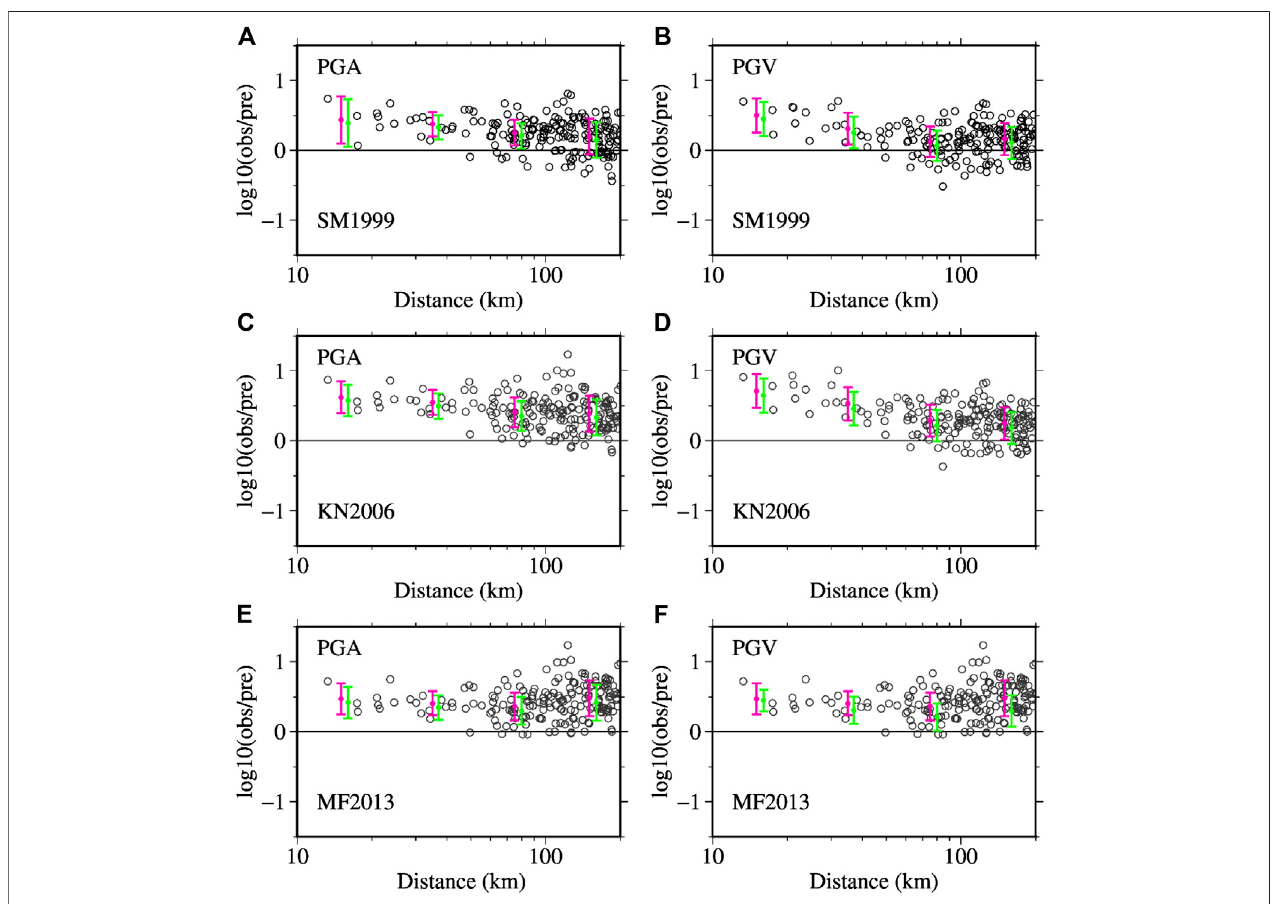
FIGURE 11 | Plots of residuals as a function of hypocentral distance after the site corrections for the data plotted in Figure 10 for the PGAs and PGVs. The fi gure parts A-F correspond to the fi gure parts in Figure 10 . The residual values shown in the plots were obtained for the Mw value of 5.5. The magenta-colored vertical bars represent the error bars for binned data with mean error and plus-minus one standard deviation. The green-colored vertical bars show the error bars for comparison for the Mw value of 5.6.